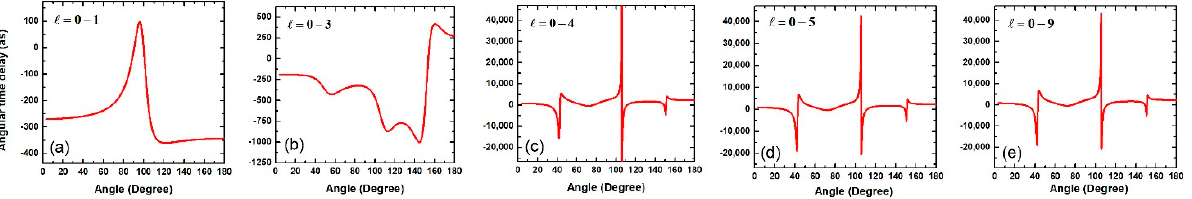
Figure 8. Angular time delay at the resonant energy E r = 0.0829 a.u. plotted for different partial wave combinations ( a ) (cid:96) = 0–1, ( b ) (cid:96) = 0–3, ( c ) (cid:96) = 0–4, ( d ) (cid:96) = 0–5 and ( e ) (cid:96) = 0–9.